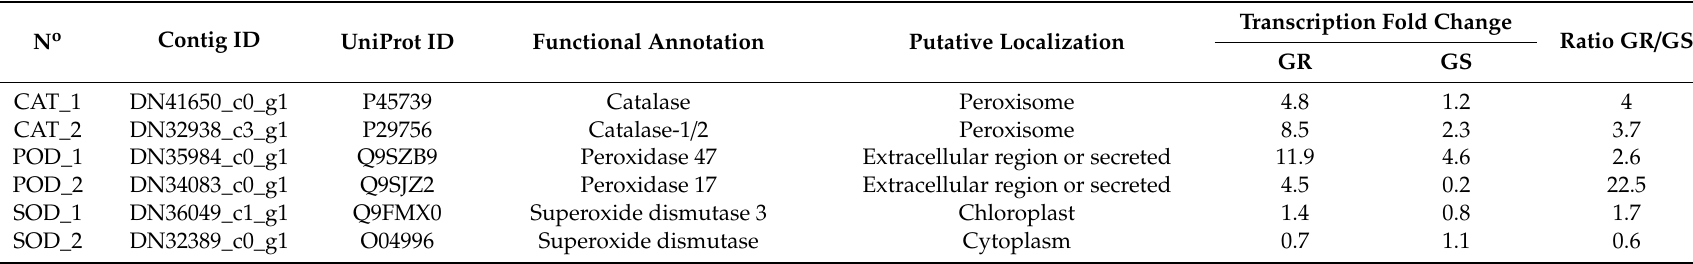
Table 4. Di ff erential expression of catalase (CAT), peroxidase (POD), and superoxide dismutase (SOD) genes via RNA-Seq analysis of glyphosate-resistant (GR) and -sensitive (GS) C. bonariensis biotypes in response to glyphosate treatment up to 288 h after treatment. The transcriptional fold change data for the GR and GS biotypes are each expressed as the ratio of the ABC transporter gene expression from glyphosate treated to untreated individuals. Therefore, a value of 1 means the gene was neither induced nor repressed. The rightmost column represents the ratio of ratios; i.e., the magnitude of e ff ect of being glyphosate-resistant. N o Contig